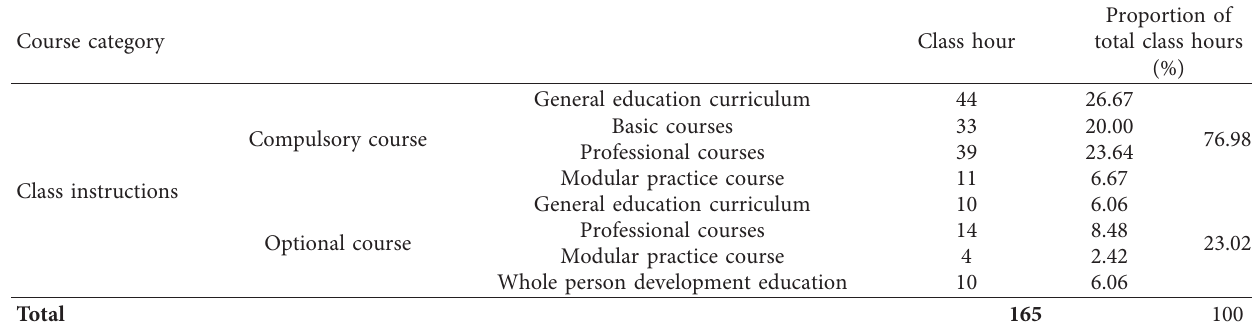
Table 4: Credit distribution.